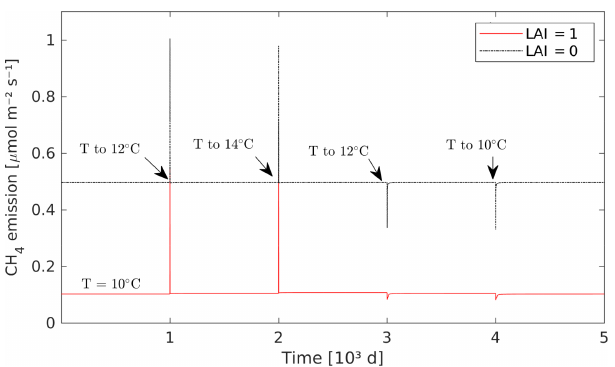
Figure 6. Output CH 4 emission responded clearly to changes in the input anoxic respiration rate in the transition tests Rtr_W0_L1 (solid line) and Rtr_W0_L0 (dashed line) (see Table 3). Black ar- rows indicate when the input changed.